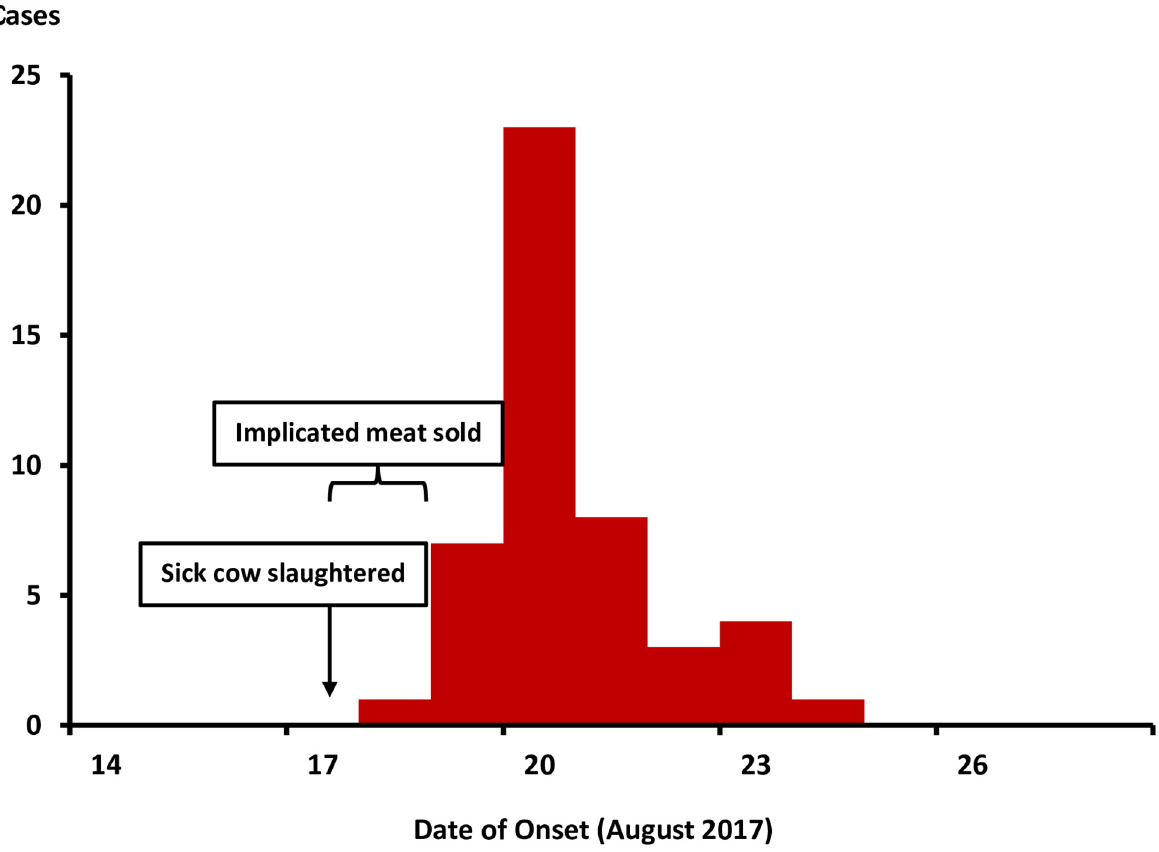
Fig 2. Distribution of symptom onset date of 61 gastrointestinal anthrax case-patients during an outbreak: Isingiro District, Uganda, August 2017.